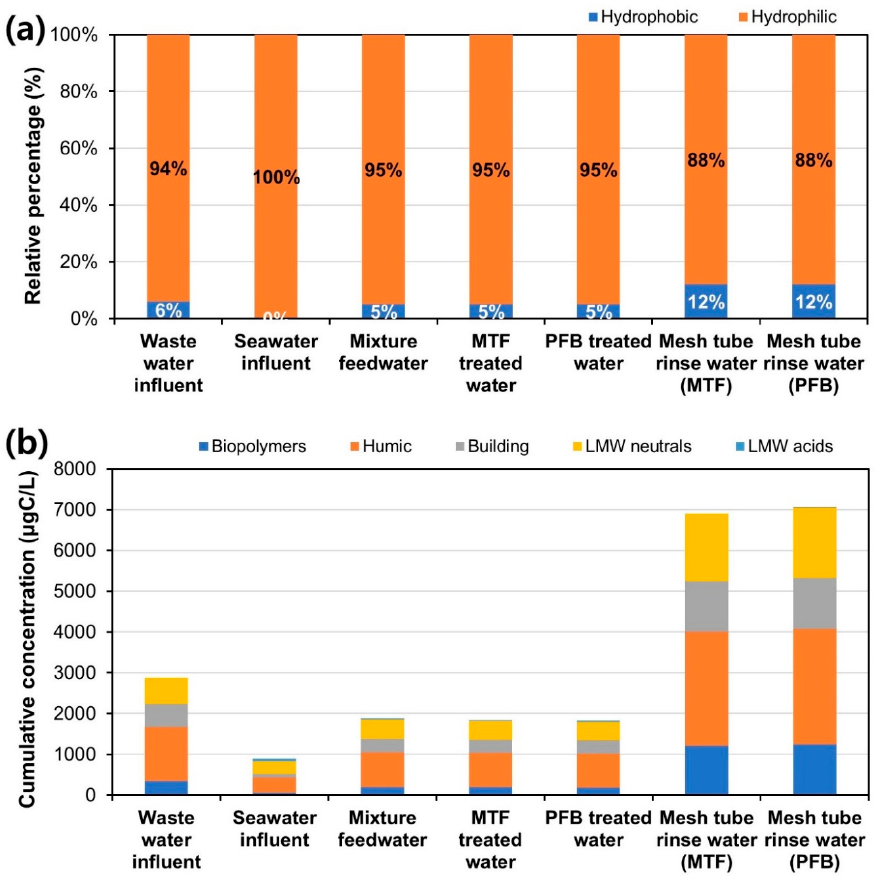
Figure 13. Liquidchromatography–organiccarbondetection(LC–OCD)analysisofthewastewater–seawater Figure 13. Liquid chromatography–organic carbon detection (LC–OCD) analysis of the wastewater– seawater mixture experiments: ( a ) hydrophobic/hydrophilic ratio of suspended organic particles and mixture experiments: ( a ) hydrophobic / hydrophilic ratio of suspended organic particles and ( b ) composition ( b ) composition ratio of suspended organic particles. ratio of suspended organic